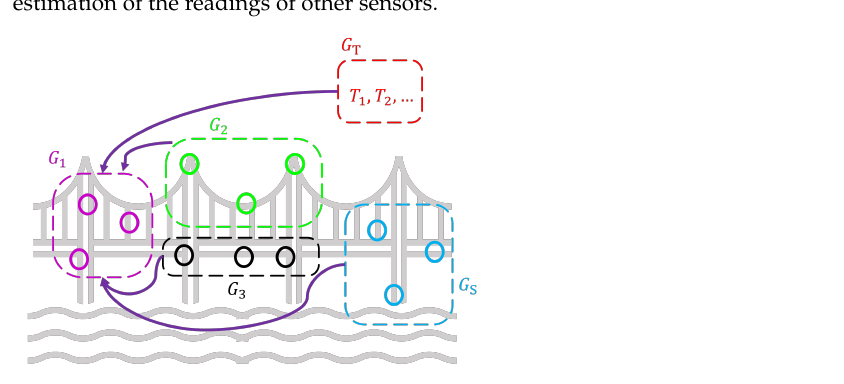
Figure 4. A model estimates the values of one group of sensors by taking all of the other groups as the